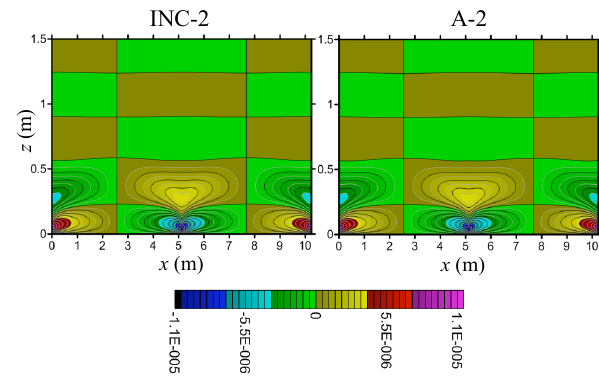
Figure 4. Vertical cross section of the analytical (A-2) buoyancy b and vertical velocity w fields from the second test case. Colour bar units are ms − 2 for b , and ms − 1 for w .